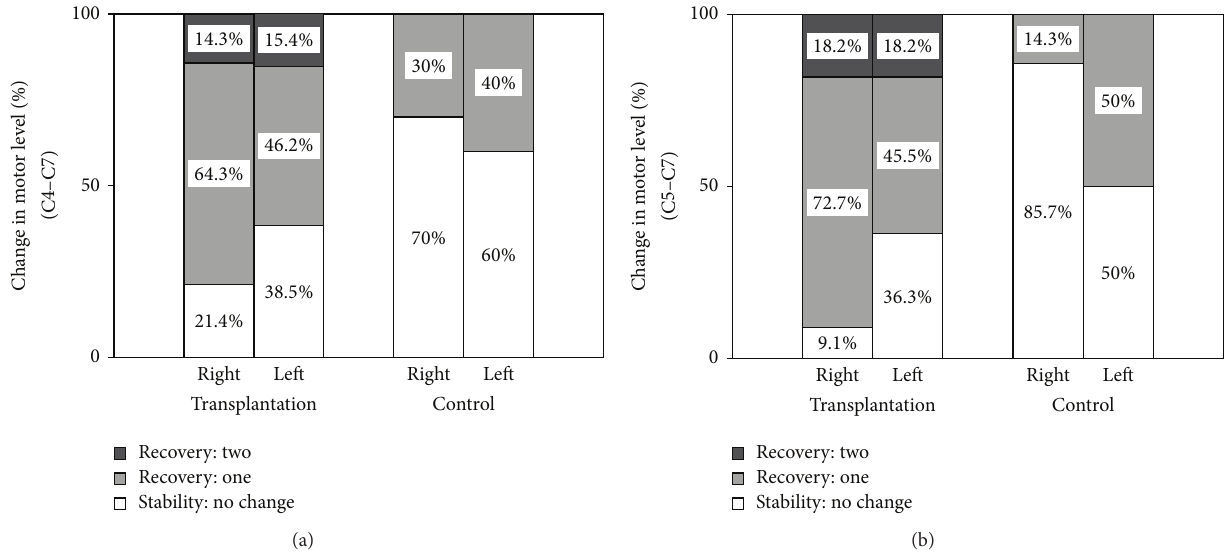
Figure 4: Proportion of AIS-A SCI individuals with initial C4–C7 (a) or C5–C7 (b) motor level remaining stable or gaining motor levels from the baseline to 1-year follow-up in the transplantation and control groups. The cervical motor level is indicated separately in the right and left sides of the cord. The percentage of individuals in each category of motor level change or stability at 1 year after the baseline assessment in both groups is displayed in each bar